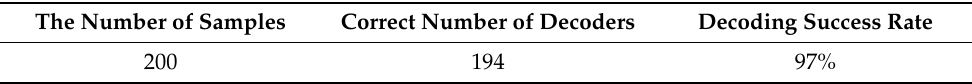
Table 6. Barcode decoding test results.